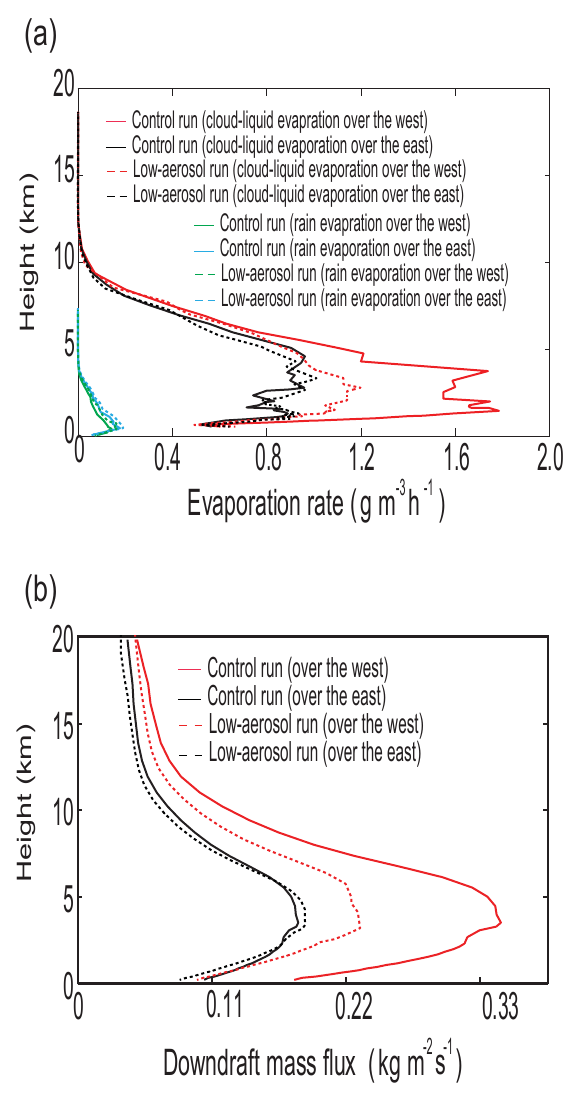
Figure 12. Vertical distributions of the time- and domain- averaged (a) cloud liquid and rain evaporation rates and (b) down- draft mass fluxes over each of the areas to the west and east of the strong convergence field for the control run and the low-aerosol run over a period between 17:00 and 19:00LST (see text for